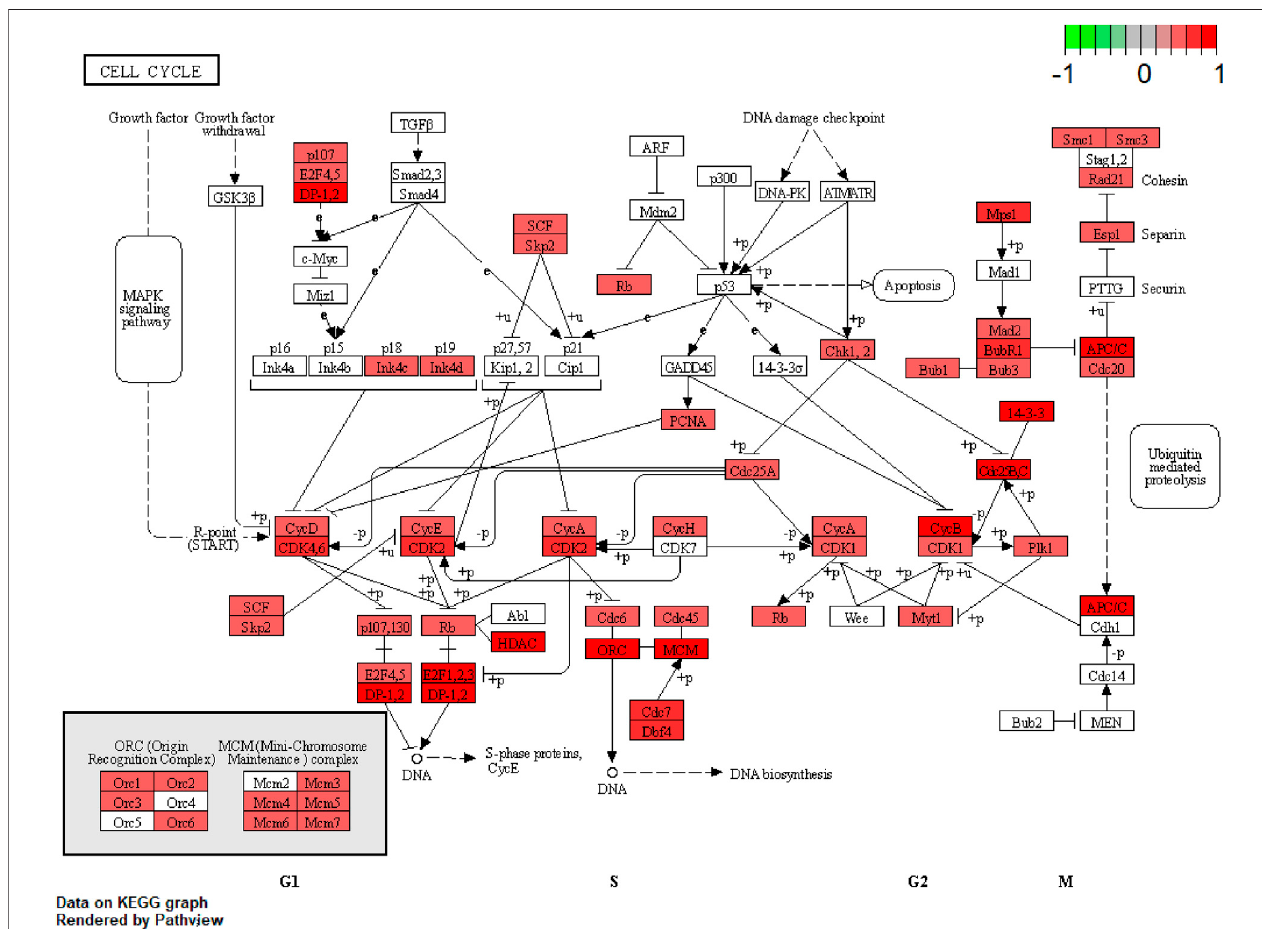
FIGURE 9 | Pathway of cell cycle. Note: Visualization of a pathway signi fi cantly enriched by KEGG analysis and performed in “ pathview ” of R software.